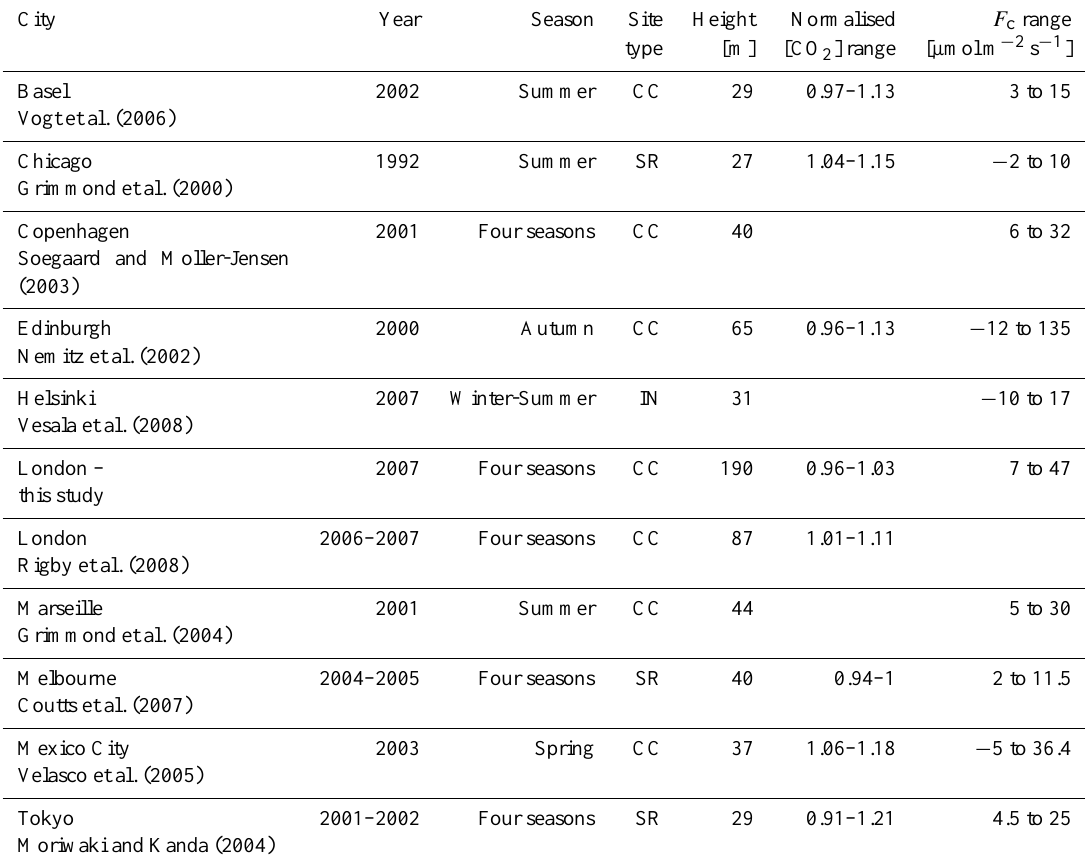
Table 4. Recent measurements of CO 2 concentrations ([CO 2 ]) and fluxes (F c ) in different urban sites (CC – city centre, SR – subur- ban/residential, IN – institutional). To aid inter-annual comparison, [CO 2 ] were normalised by their concurrent background levels measured at the Mauna Loa observatory (Tans,